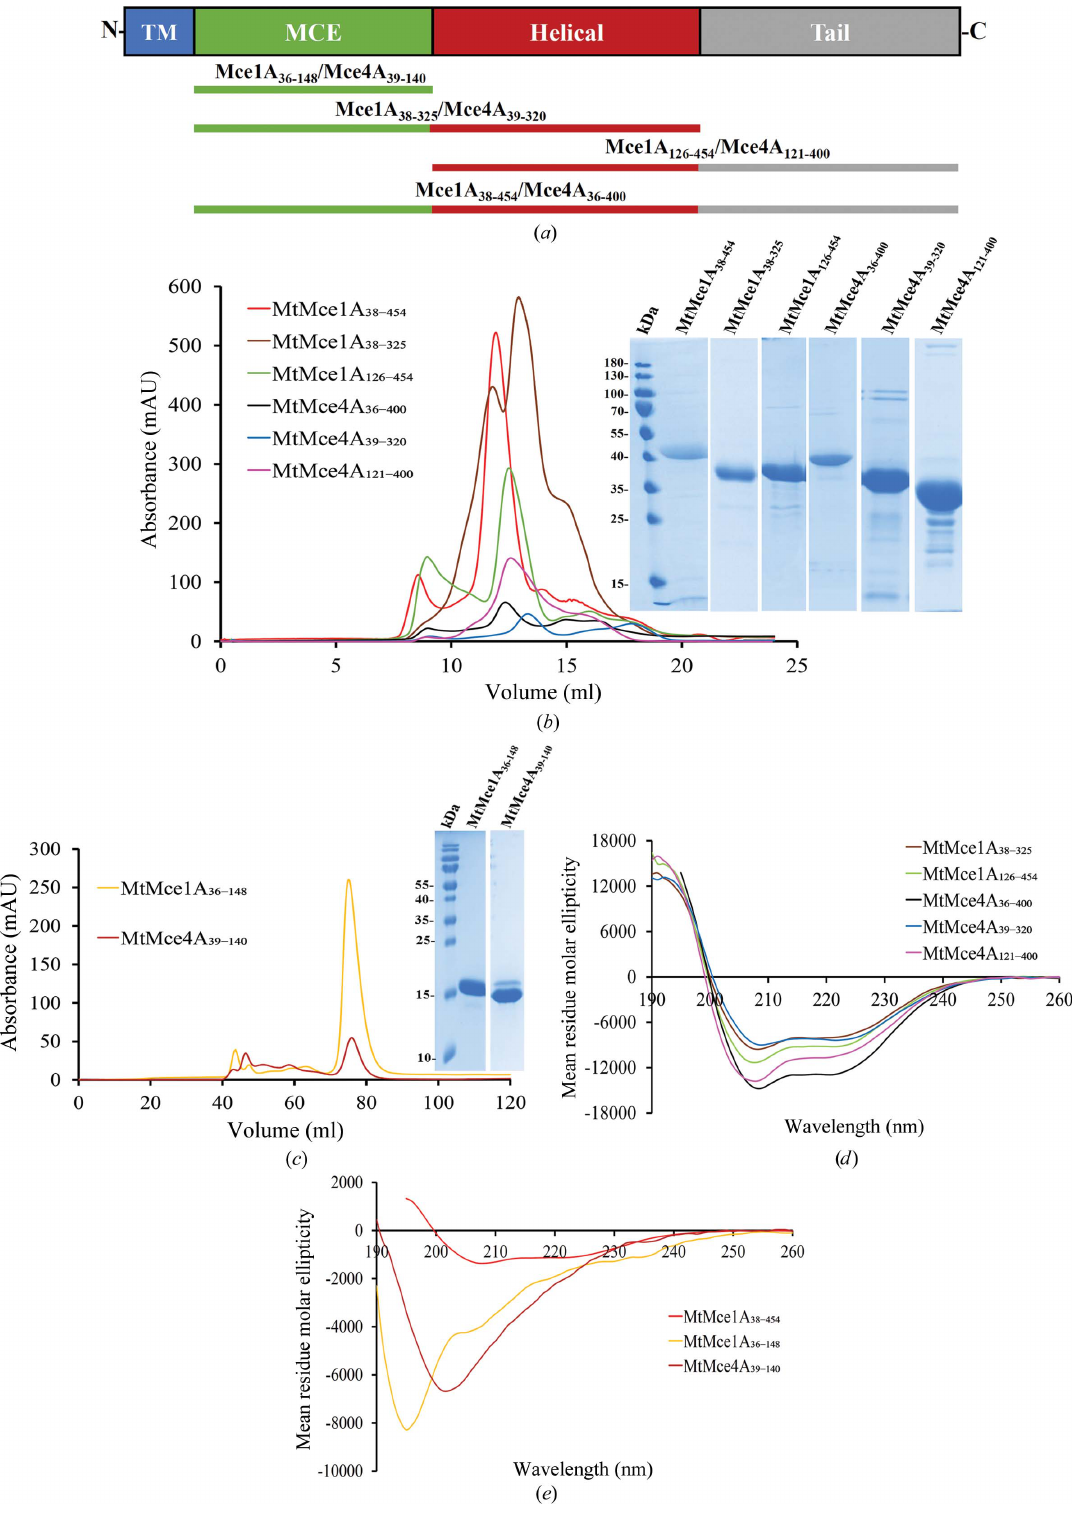
Figure 2 ( a ) The domains of the Mce SBPs. The Mce SBPs are characterized by having four domains referred to as the transmembrane (TM), MCE, helical and tail domains. The constructs of MtMce1A and MtMce4Aused in this study are shown below in the same color coding. ( b ) Size-exclusion chromatography (SEC) elution profiles of